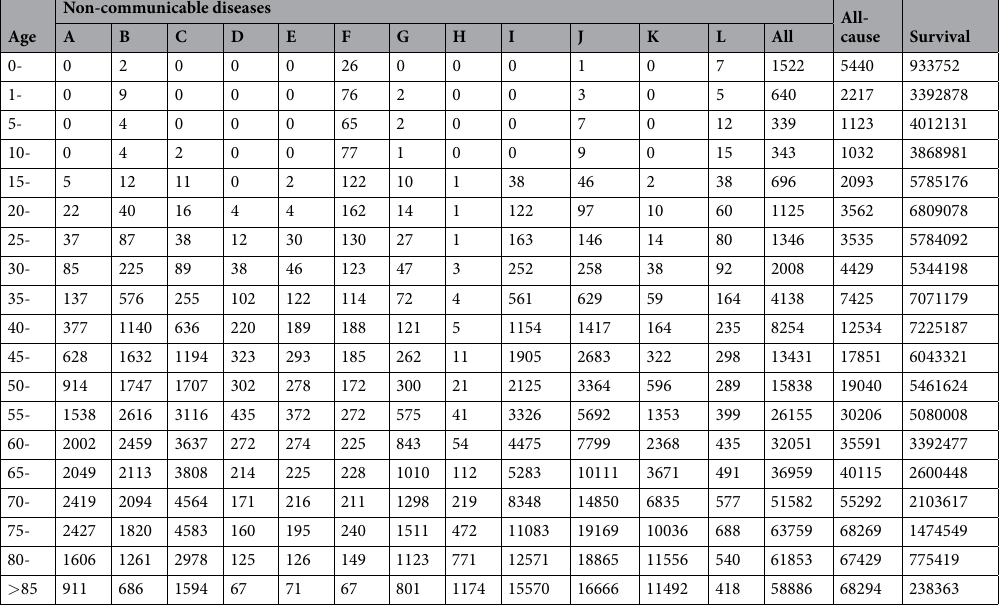
Table 2. Age-stratified number of deaths from major chronic diseases in 2011 in China 10 . Diseases classified by ICD-10 code: A: stomach cancer (C16); B: liver cancer (C22); C: lung cancer (C33-34); D: breast cancer (C50); E: cervix uteri and uterine cancer (C53-55); F: leukaemia (C91-95); G: diabetes (E10-14); H: Alzheimer’s